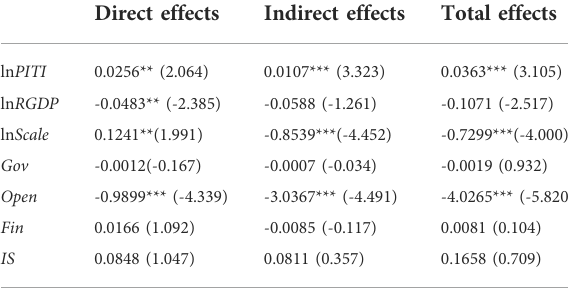
TABLE 6 Direct effect, indirect effect, and total